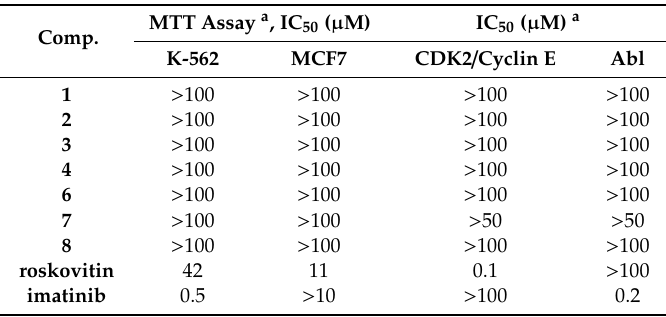
Table 1. Protein kinase inhibitory activity and the cytotoxic activity of tested pyrazolo[4,3- e ] [1,2,4]triazines and standard after 72 h incubation.